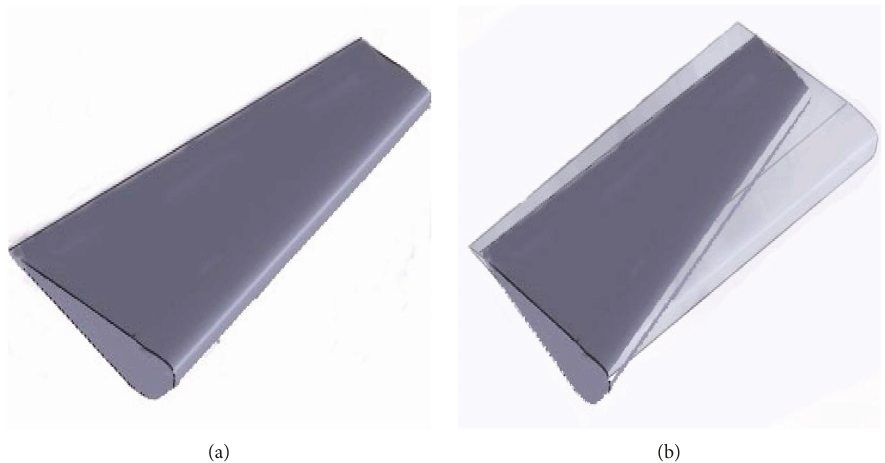
Figure 3: Tapered helicopter blade. (a) Tapered blade. (b) Both tapered and untapered blades.